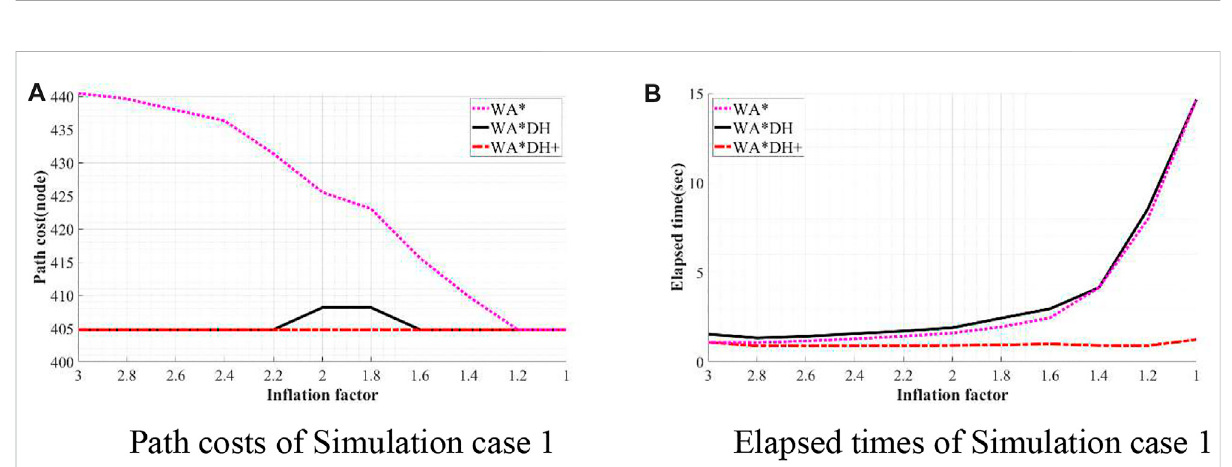
FIGURE 11 Result of simulation case 1. (A) Path costs of simulation case 1. (B) Elapsed times of simulation case